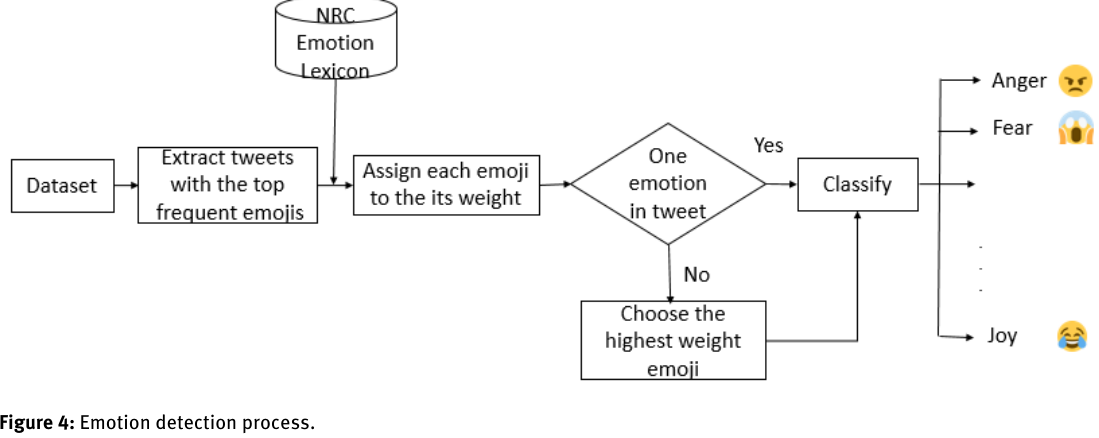
Figure 4: Emotion detection process.